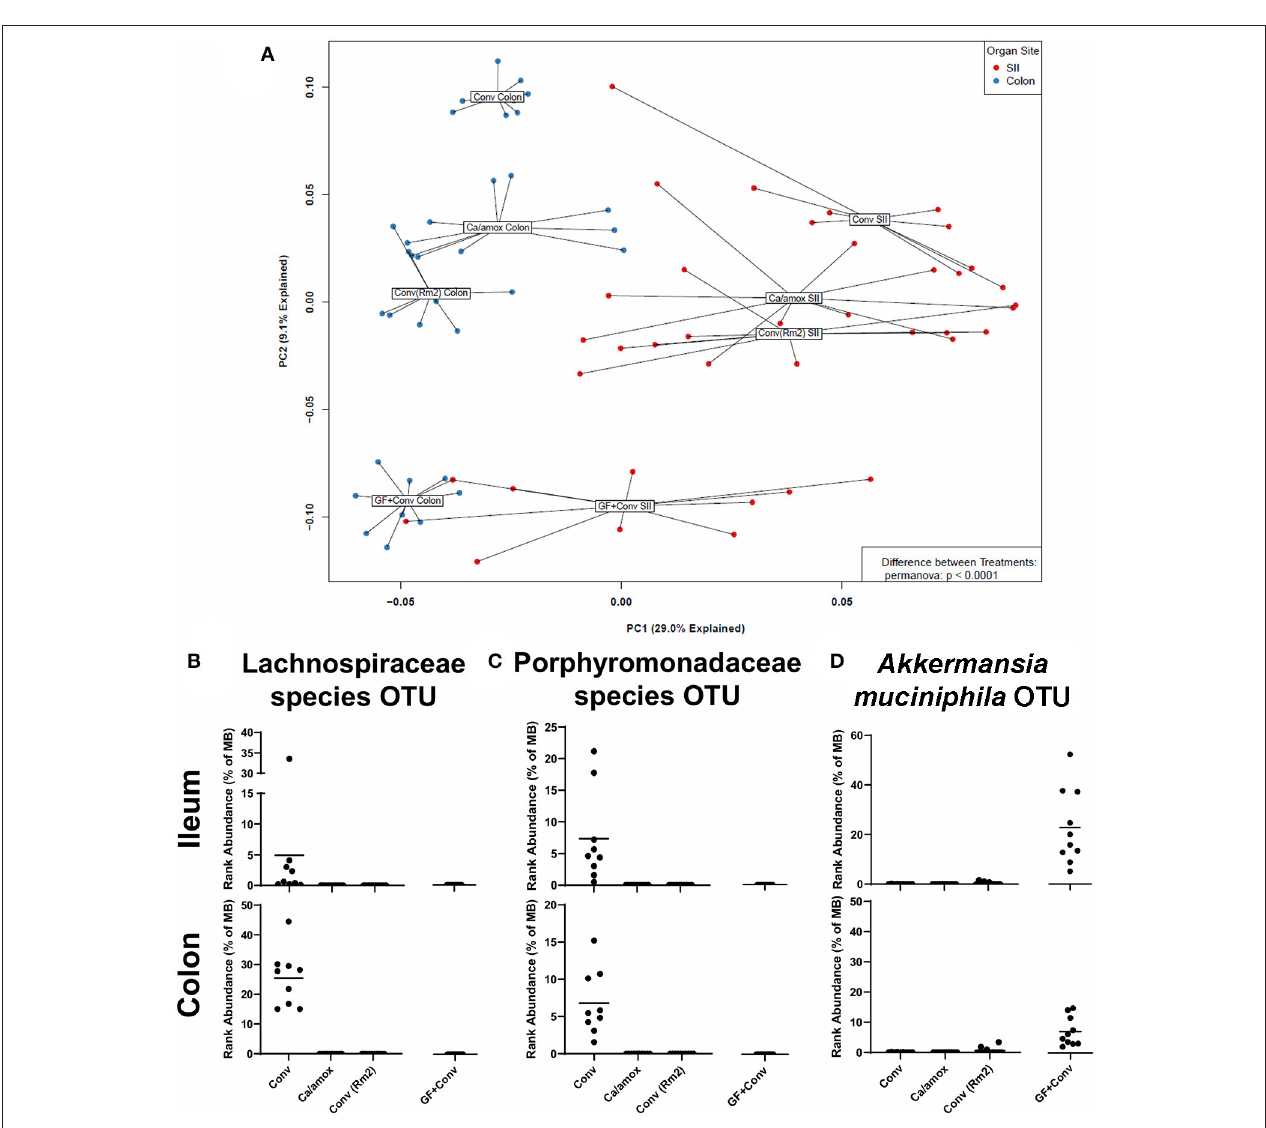
FIGURE 8 | Disparate microbiome composition in the small intestine ileum (SII) and colon of Conv, Ca/amox, Conv (Rm2), and GF + Conv mice after oral antigen exposure. The four experimental groups were treated according to Figures 1A , 4A . Tissue snips of the ileum and colon were collected post-oral antigen exposure on D28 (Conv Rm2 and Conv) or D42 (GF + Conv and Ca/amox), and DNA of the mucosally-associated bacteria was extracted for 16s rRNA sequencing. (A) PCA of distinct bacterial communities in the ileum and colon of the four groups after sensitization and challenge to OVA. (B-D) Percent rank abundance of three dominant species within the microbiome of the Conv or GF + Conv mice. Each dot represents a single mouse, and the p -values were determined with a permanova. See 16s rRNA Sequencing and Microbiome Analysis section for detailed methods of microbiome data